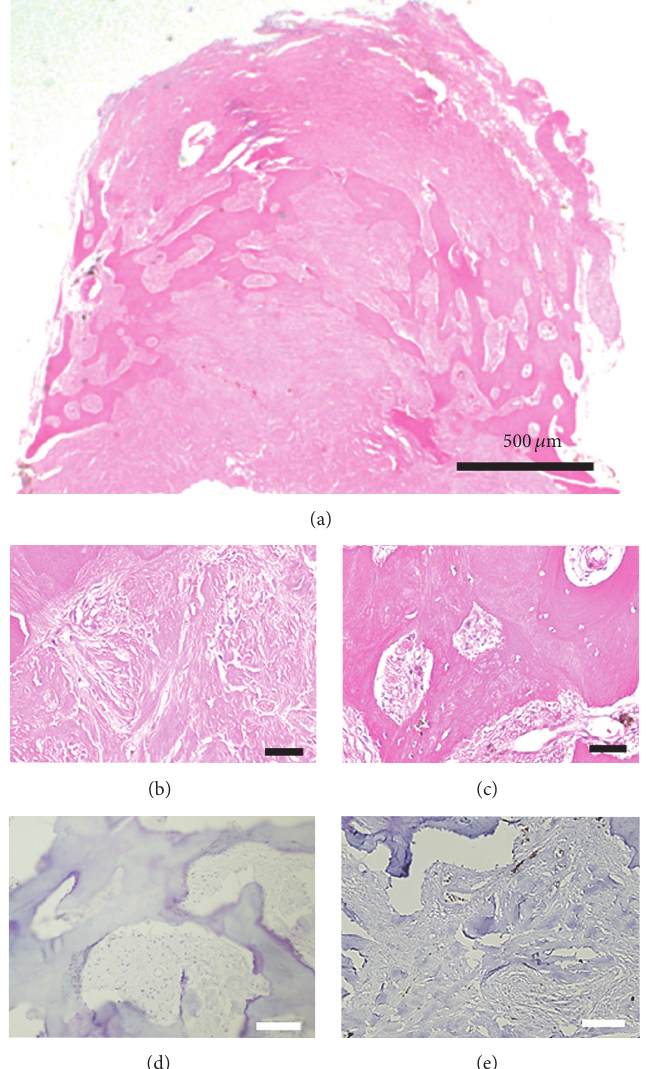
Figure 4: The histopathological finding of the surgically extracted tumor. (a) Hematoxylin-eosin staining of the whole image of extracted tumor. Magnified picture of part of (a) shows hyalinization (b) and bone formation (c). The immunostaining for epithelial membrane antigen (d) and glial fibrillary acidic protein (e) was negative (scale bar: black bar = 20 𝜇 m; white bar = 50 𝜇